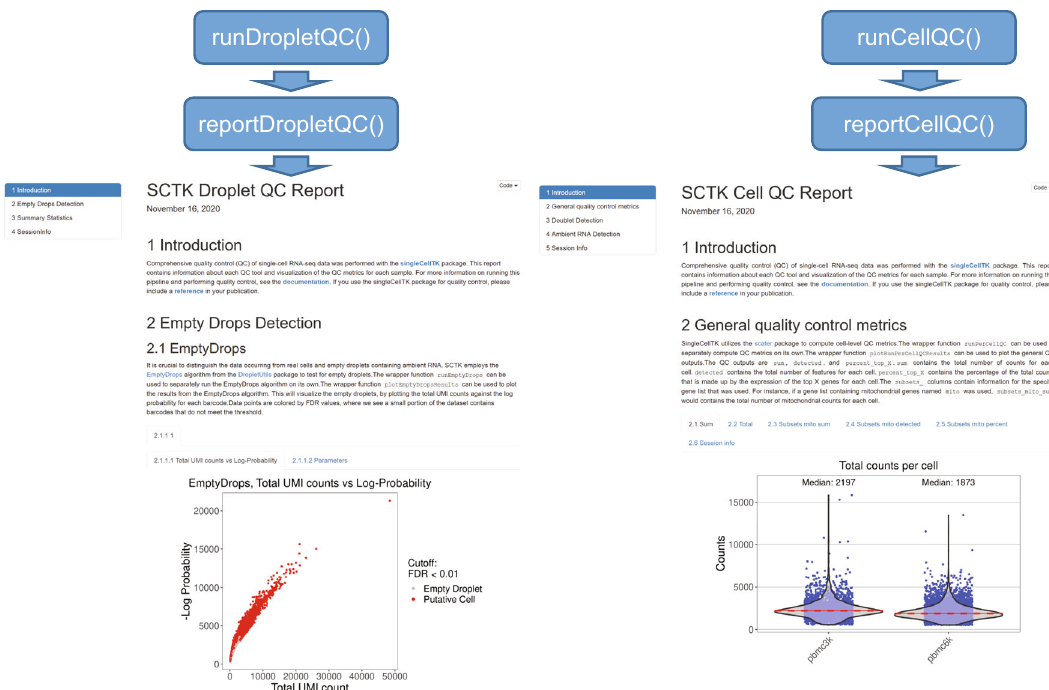
Fig. 2 Generation of HTML reports for visualization and assessment of QC metrics. The functions reportDropletQC() and reportCellQC() generate the extensive HTML reports to display data generated by the various QC tools applied by the functions runDropletQC() and runCellQC() , respectively. The reportDropletQC() report contains fi gures visualizing identi fi ed empty droplets. The reportCellQC() report contains visualizations of total read counts, total genes detected, doublet scores, doublet calls, percentages of ambient RNA detected, and cell clusters identi fi ed by decontX. These reports are run automatically by the SCTK-QC pipeline. Examples of reportDropletQC() (on the left ) and reportCellQC() (on the right) reports are